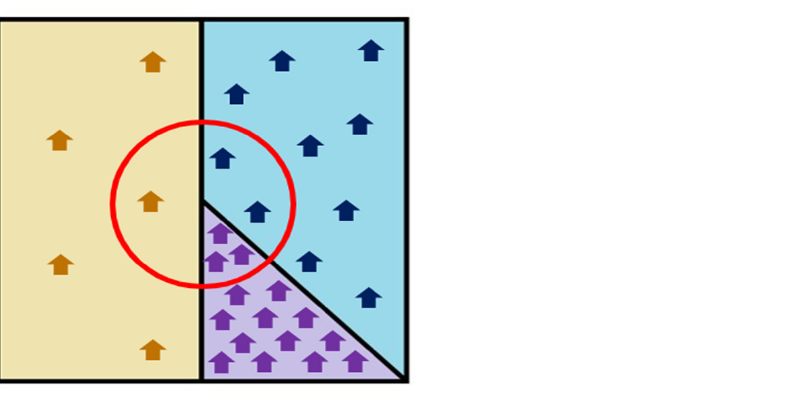
Figure 3. When a fire (in red) touches, proportionally, the department within the DFCI mesh, the density of the houses is applied, and we obtain the number of houses burnt and the damage